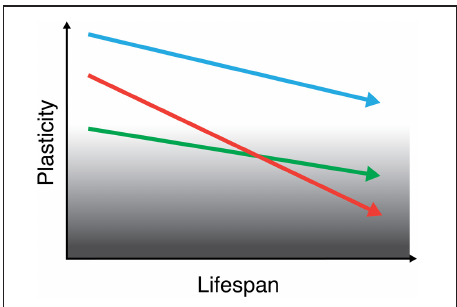
FIGURE 3 | Schematic representation of brain plasticity across the lifespan. Brain plasticity progressively declines throughout the (adult) lifespan, putatively underlying a decline in cognitive function. Although mechanisms of plasticity show a downward trend over the course of a typical lifetime, this trend will manifest differently according to initial “baseline” levels, genetic factors, and environmental influences. Therefore, each individual may have a unique “slope of plasticity” across the lifespan. Assessing the trajectories of brain plasticity across each individual’s lifespan may shed light into how the brain continues to sustain healthy functionality throughout life in some individuals and how functionality is impaired, ultimately leading to the manifestation of brain disease, in others. Lines in figure intend to depict the life-course of three different